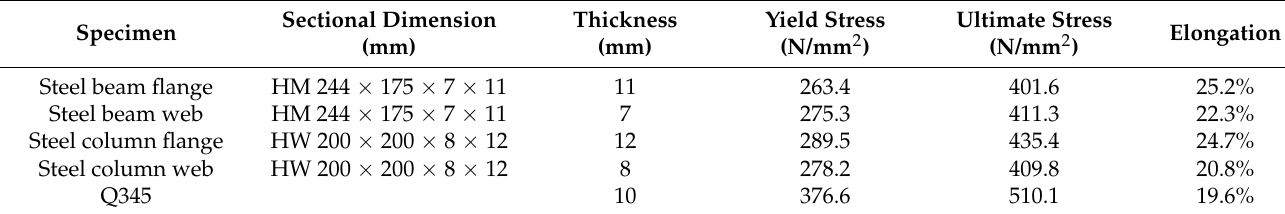
Table 2. Mechanical properties of steel.